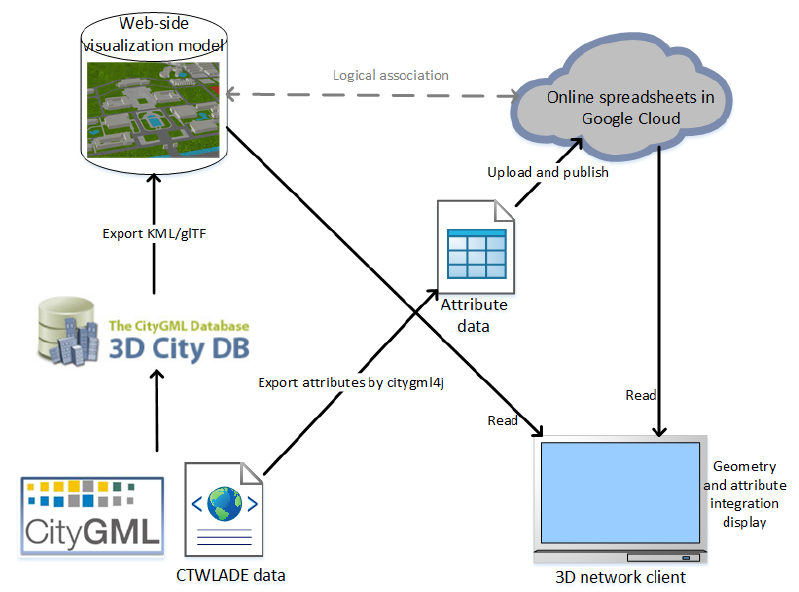
Figure 13. 3D visualization process of integrating attribute information.